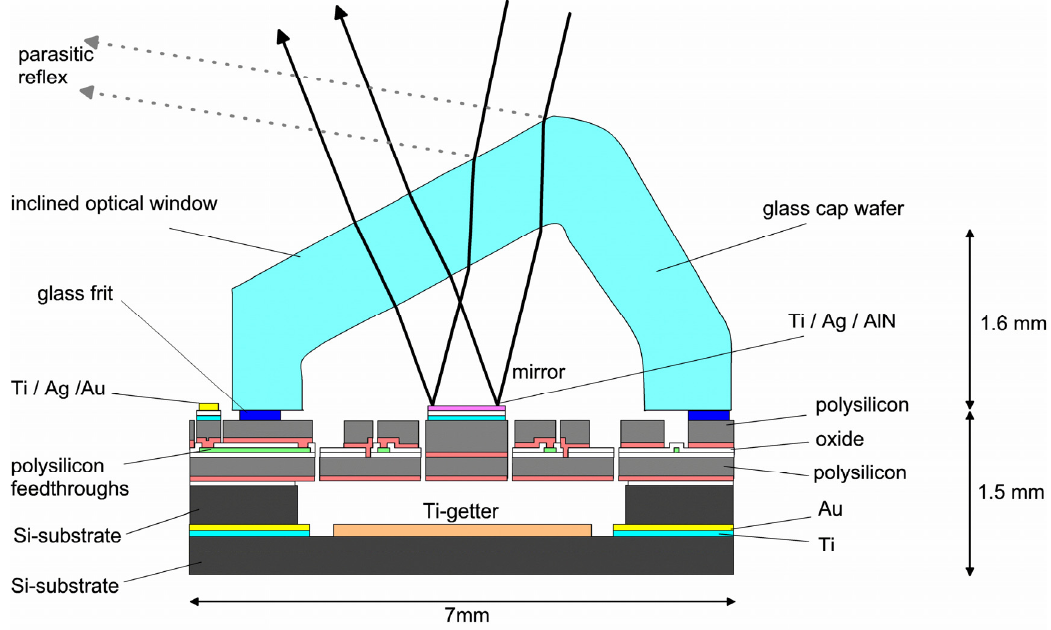
Figure 23. Schematic cross-section of packaged MEMS mirror with tilted optical window.